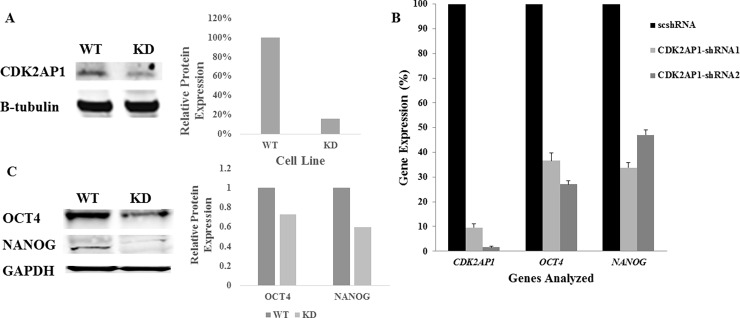
Knockdown of CDK2AP1 in hESCs reduces OCT4 and NANOG expression.A. Whole cell lysates were used to examine levels of CDK2AP1 protein in WA09 hESCs transduced with CDK2AP1 specific shRNA1 (right lane) or a control (left). Cells that were transduced with CDK2AP1 specific shRNA1 had lower CDK2AP1 protein levels. Densitometric analysis of the protein levels of the Western blot is presented in the right panel. B. WA09 hESCs that were transduced with CDK2AP1-shRNA1, CDK2AP1-shRNA2 or a scrambled shRNA (scshRNA) were examined for CDK2AP1 knockdown and for OCT4 and NANOG expression. Knockdown of CDK2AP1 using CDK2AP1-shRNA1 and CDK2AP1-shRNA2 resulted in reduction in OCT4 and NANOG expression when compared with hESCs that were transduced with the scshRNA(p-value < 0.05). Results are presented together with standard deviation from experiments conducted in triplicate. C. Whole cell lysates from WA09 hESCs transduced with CDK2AP1-shRNA1 (right lane) or scshRNA(left) were examined by Western Analysis and demonstrated reduction in OCT4 and NANOG levels. Densitometric analysis of the protein levels of the Western blot is presented in the right panel.